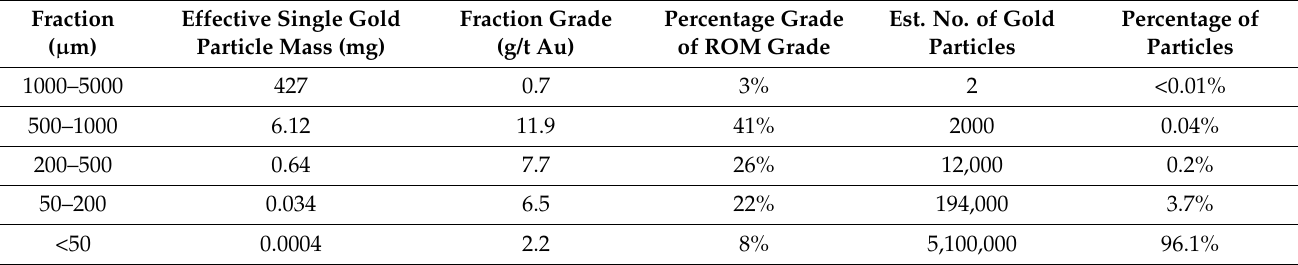
Table 13. Theoretical estimate of the number of gold particles in one tonne of ROM (29 g/t Au) grade ore. Fraction ( µ m)